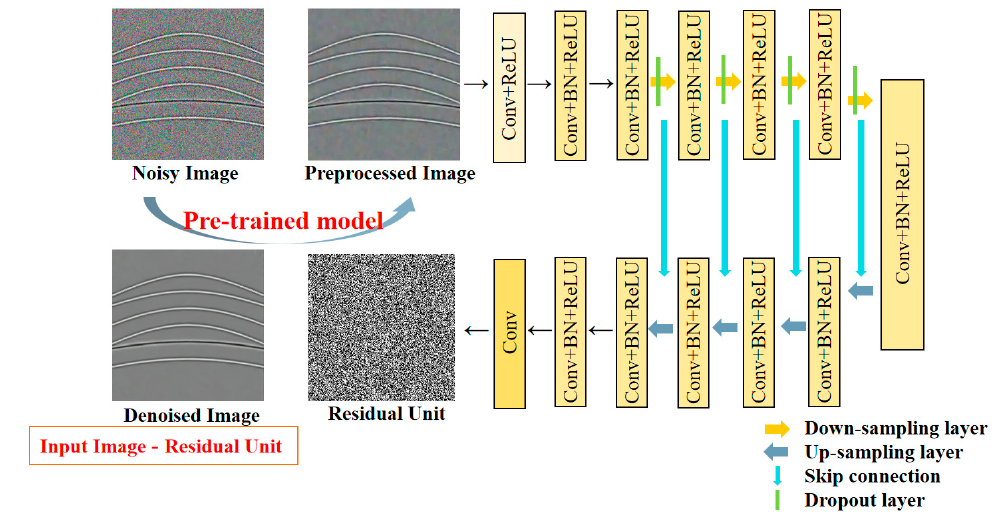
Figure 3. Network architecture in the post-trained model.